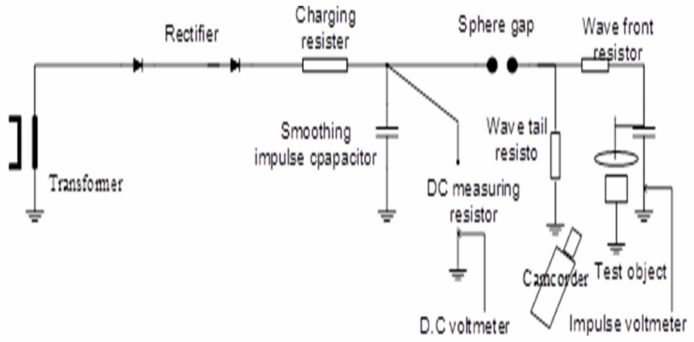
Figure 1. Schematic diagram of the experimental